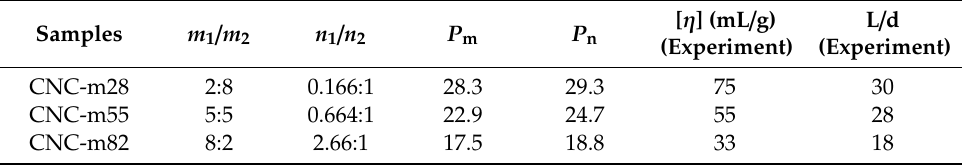
Table 2. Mass ratio, number ratio, number average L / d, mass average L / d, intrinsic viscosity,